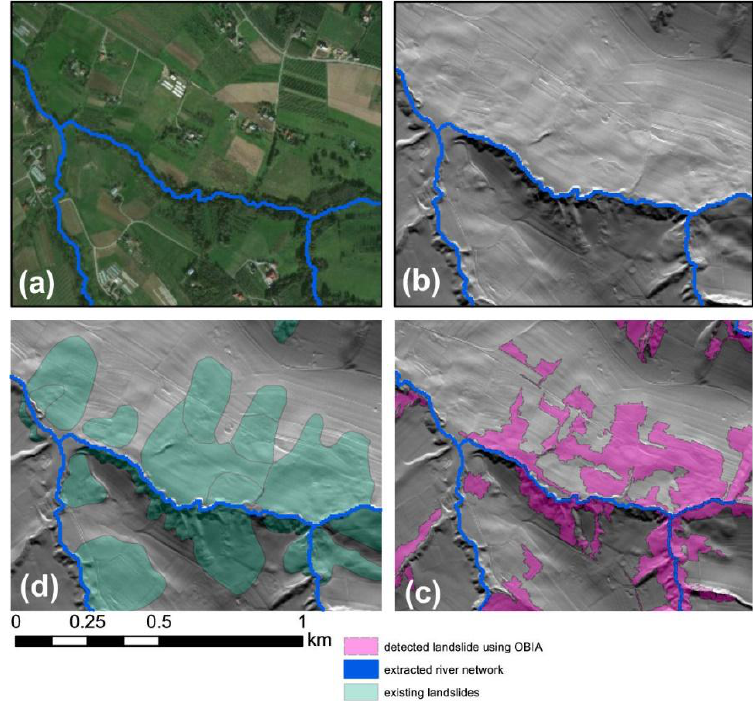
Figure 10. OBIA in agricultural areas: ( a ) Ortophoto, ( b ) shaded DEM, ( c ) landslide detected using OBIA, and ( d ) existing landslide in SOPO